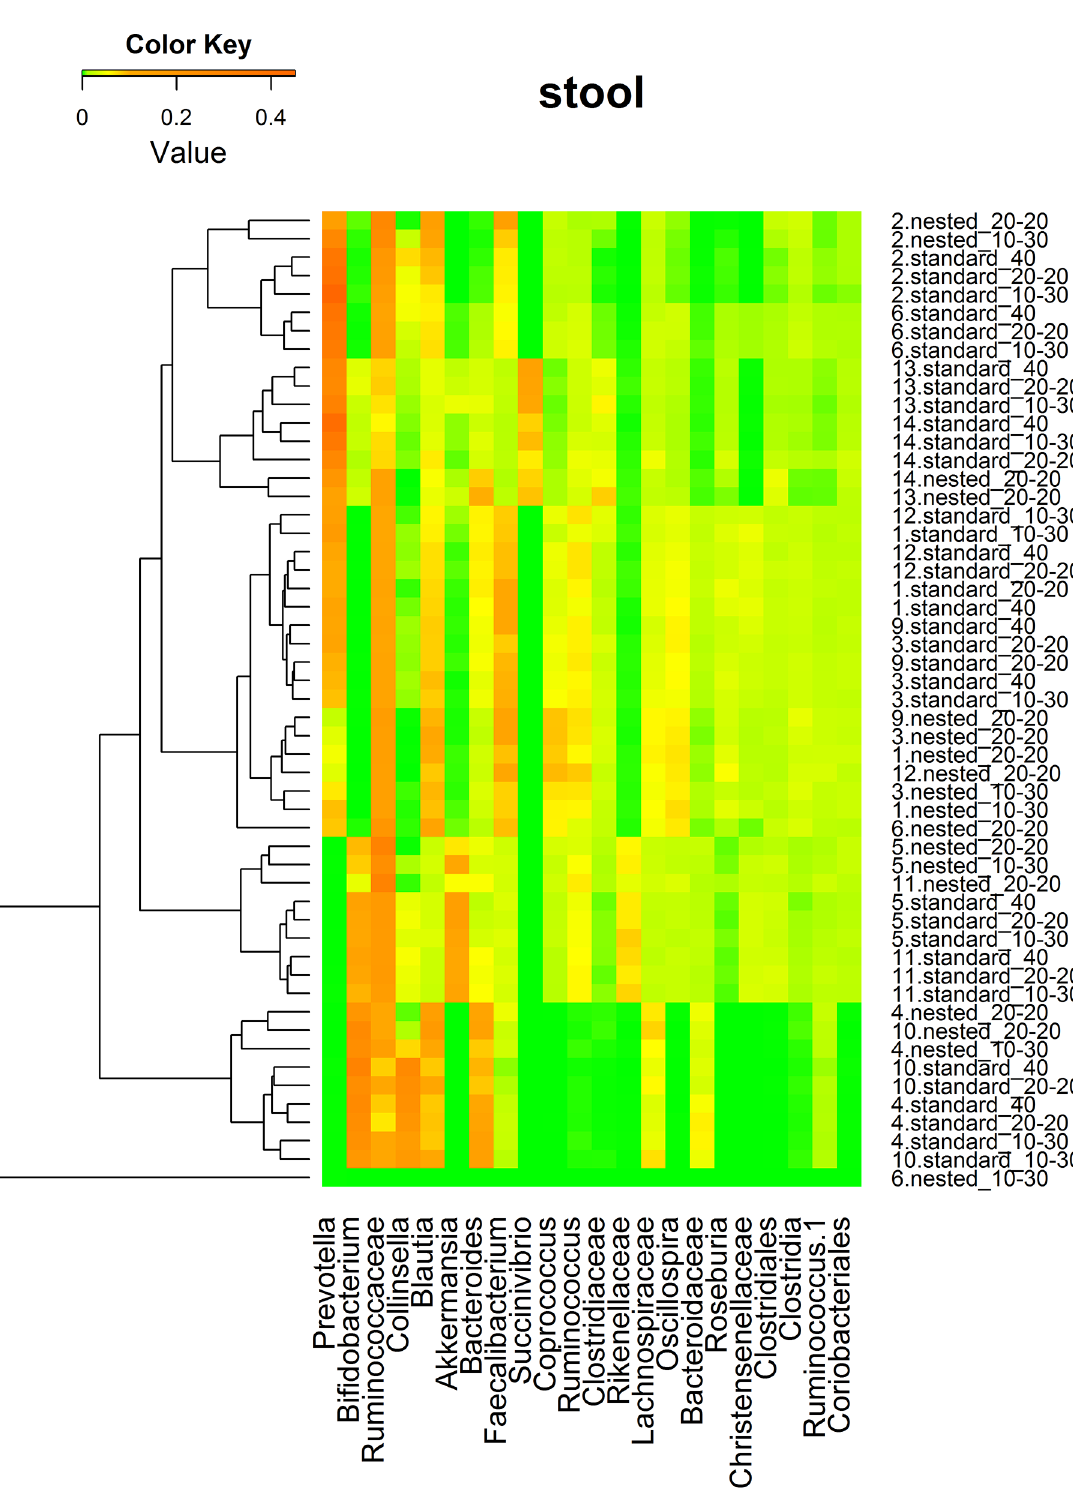
PLOS ONE | DOI:10.1371/journal.pone.0132253 July 21,